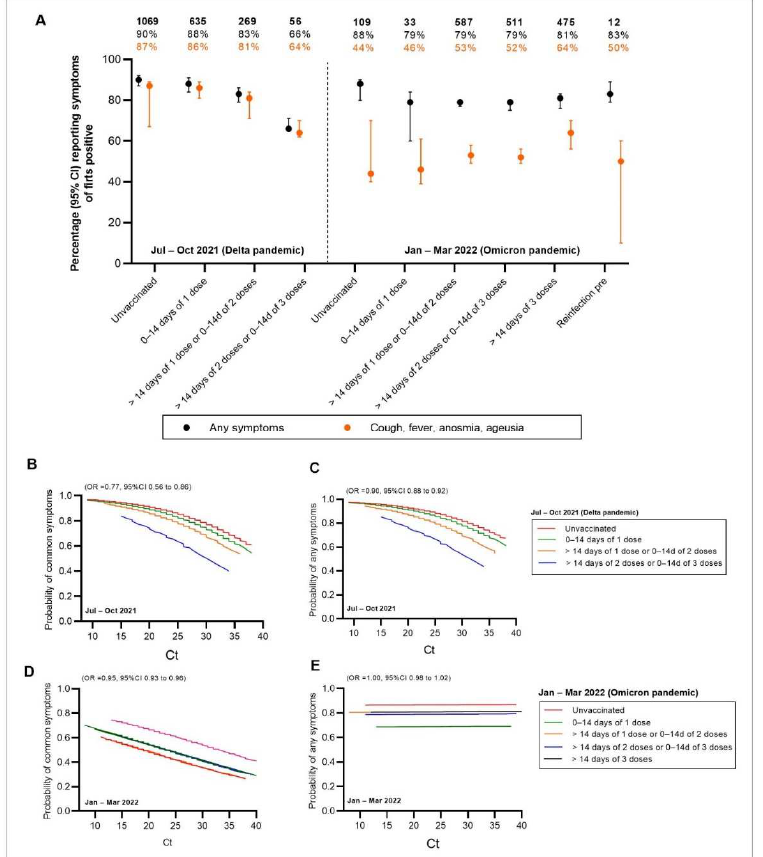
Figure 4. Ct value trajectories of confirmed COVID-19 infection and symptoms during the Delta and Omicron pandemics in vaccinated and unvaccinated individuals. ( A ) Self-report symptoms in PCR- positives by numbers of vaccination/reinfection status. Probability of reporting common ( B , D ) fever, cough, anosmia, or ageusia or ( C , E ) any symptoms by Ct values and vaccination status in PCR- positives.